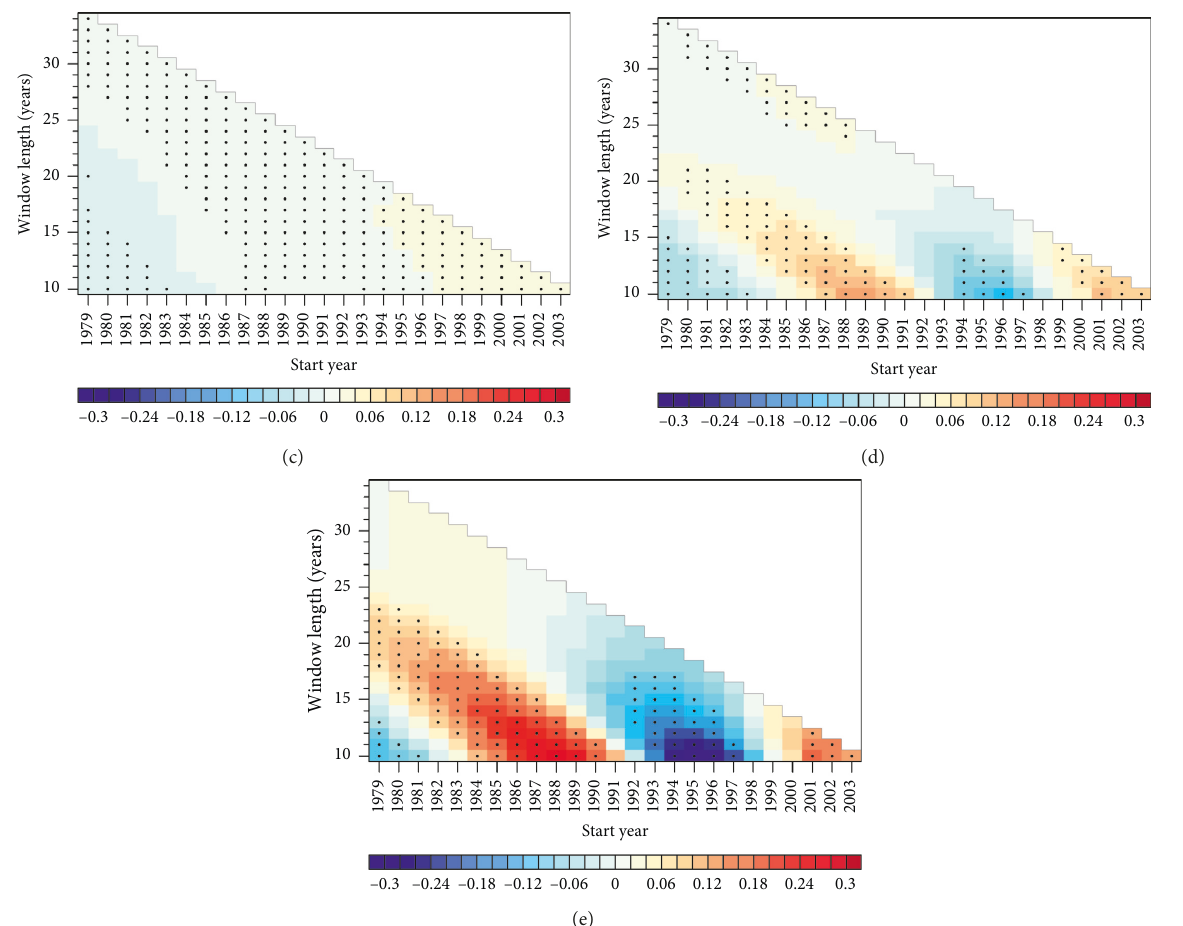
Figure 6: Running trend analysis for (a) annual and (b–e) seasonal mean sampling error variances of all grid boxes starting from 1979 to 1988 and ending in 2012, with at least a 10-year span required to calculate the trend. The x -axis and y -axis indicate the start year and the length of the time series used to calculate trend, respectively. The color of the rectangles represents the intensity of the trend and those with black dots represent mean trends above the 95% significance level: (a) annual; (b) spring; (c) summer; (d) autumn; (e) winter.